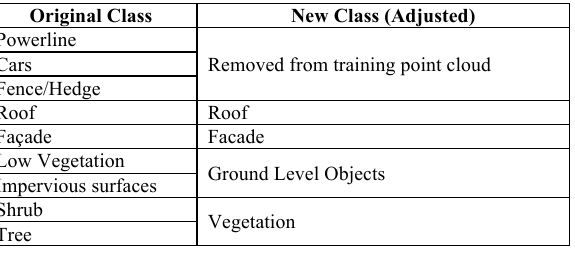
Table 3. Adjustments in the original Vaihingen dataset in order to classify the available point cloud in only 4 classes.